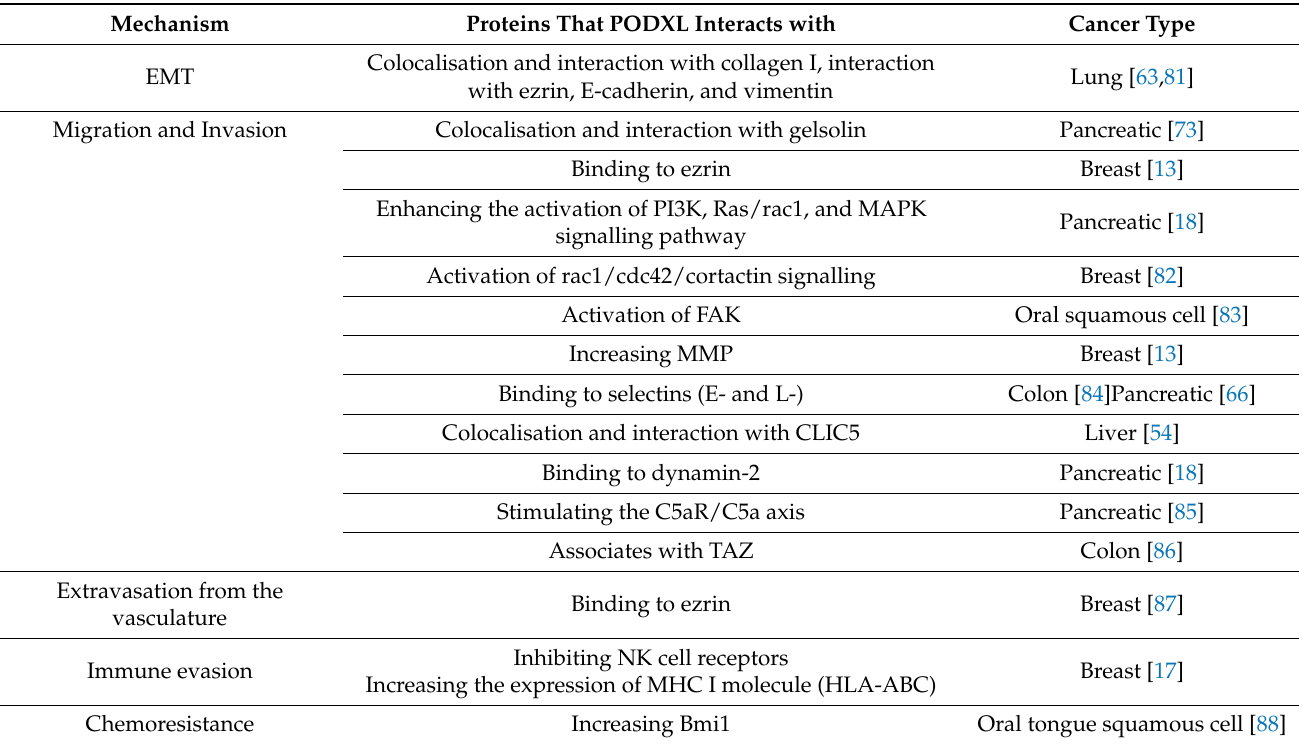
Table 2. Proposed PODXL mechanisms in cancer